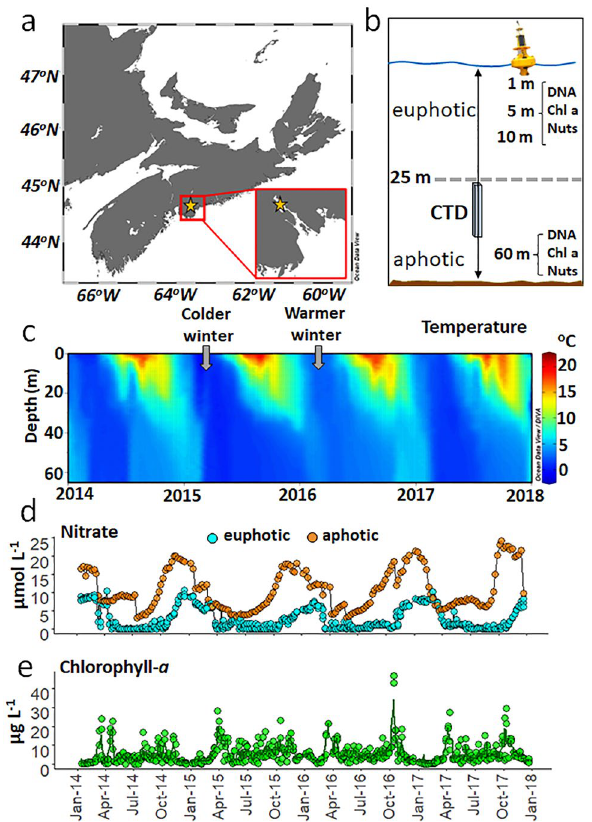
Figure 1. Our sampling site was located in Nova Scotia, Canada ( a ), and specifically within the Bedford Basin [inset of a ; sampling site (star) is also known as HL0 = 44.6936 latitude, −63.6403 longitude]. ( b ) Schematic representation of variables and conditions measured during this study, included: sampling depths for DNA, chlorophyll- a and concentrations for dissolved nutrients (nuts; which included PO 4 − , NO 3 − , NO 2 − , NH 4 + and Si) along with CTD profiles. Weekly measurements from 2014 to 2017 included: temperature profiles ( c ), nitrate concentrations in the euphotic (1, 5 and 10 m; cyan circles) and in the aphotic zone (60 m; orange circles; d ), and chlorophyll- a concentrations in the euphotic zone (the green line is the average for the three depths 1, 5 and 10 m; e ). Grey arrows denote colder and warmer winters for 2015 and 2016, respectively, as detailed by Haas et al. 32 . Image credit for yellow buoy; Robert